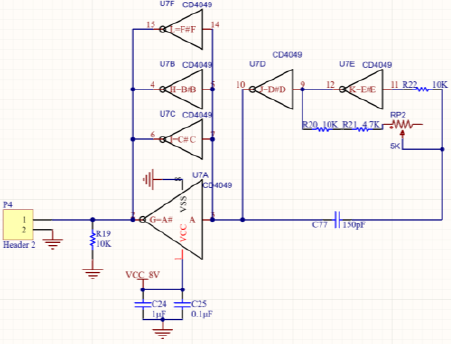
Fig. 4. Ultrasonic transmitter module.